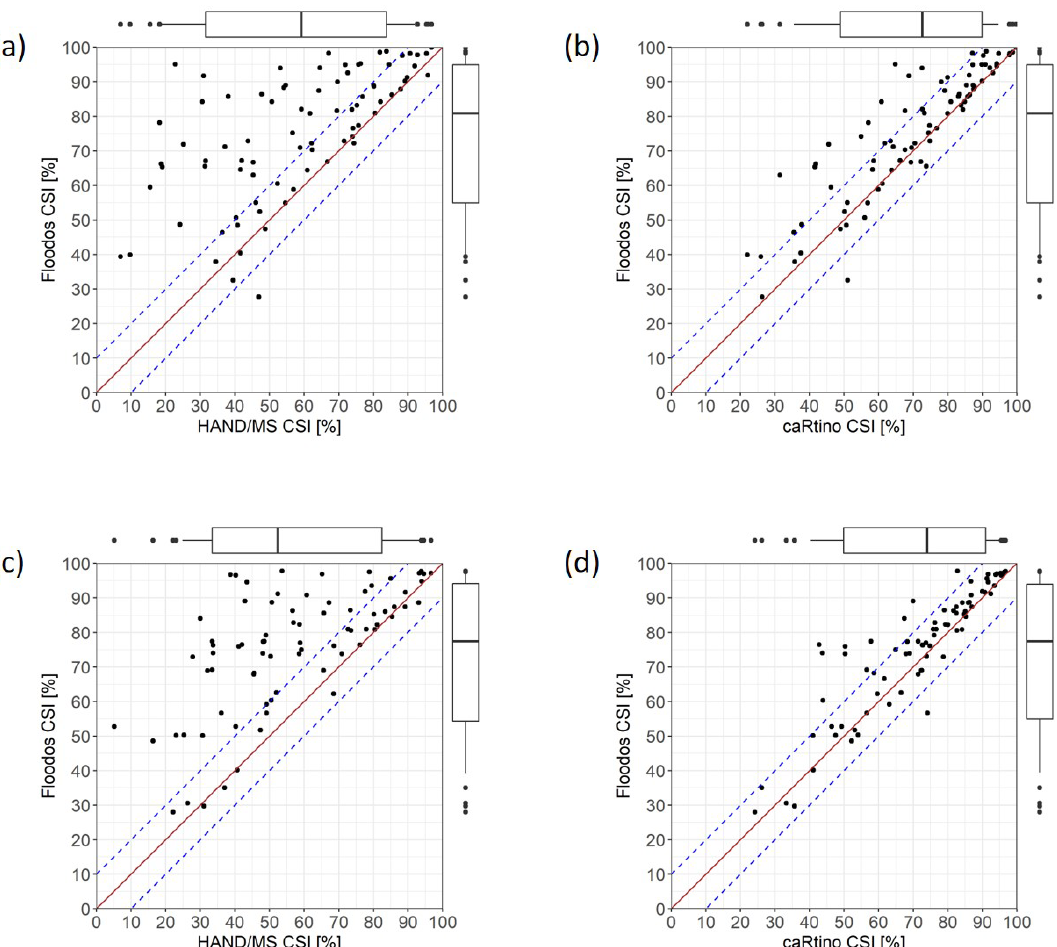
Figure 5. Comparison of CSIs computed for the river reaches, including the following: (a) HAND/MS vs. Floodos – Argens 2010 event; (b) caRtino 1D vs. Floodos – Argens 2010 event; (c) HAND/MS vs. Floodos – Aude 2018 event; and (d) caRtino 1D vs. Floodos – Aude 2018 event. The box plots represent, respectively, the 5% and 95% (whiskers) and the 15% and 85% quantiles